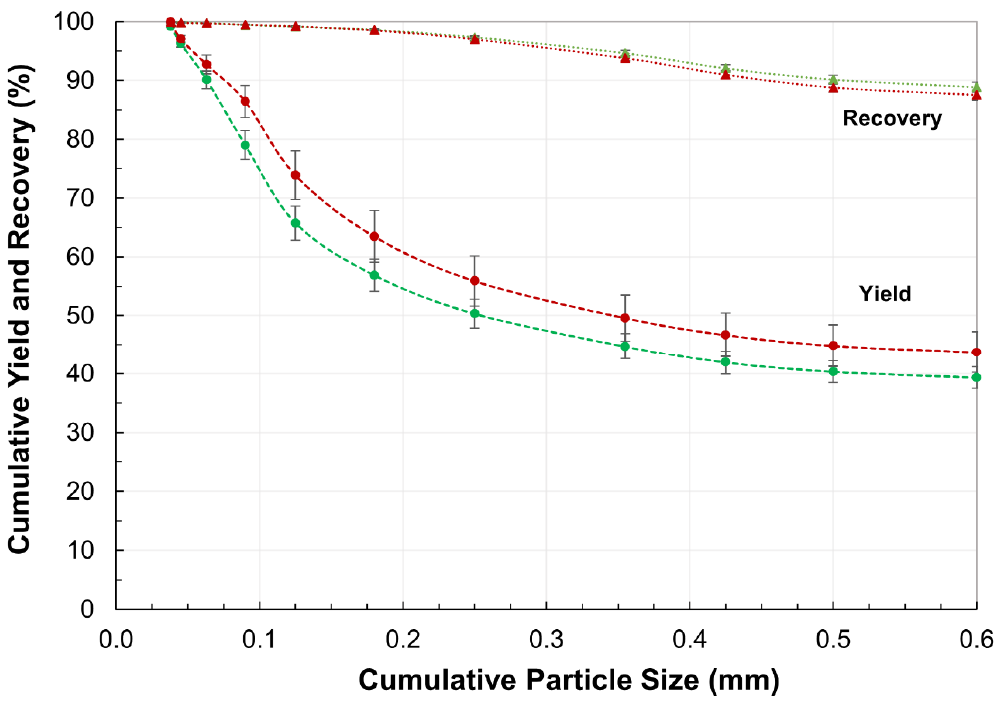
Figure 9. Cumulative yield (circles and broken line) and cumulative recovery (triangles and dotted line) for the best (green) and poorer (red) performing gas fluxes. Best performance had a gas flux of 0.15 cm/s and poorer performance had a gas flux of 0.45 cm/s.